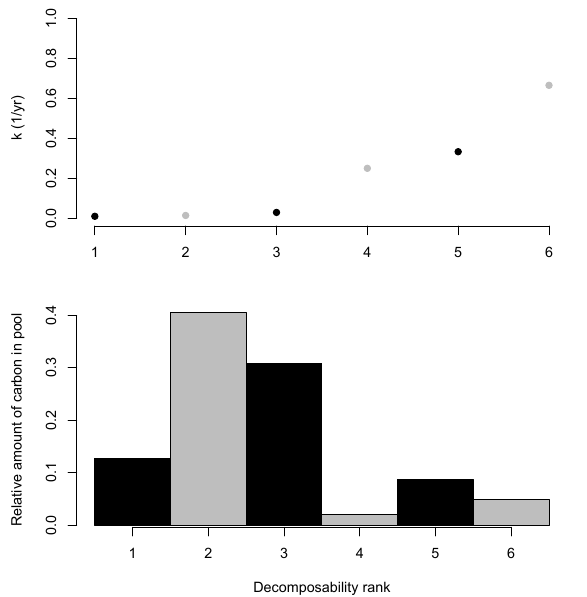
Fig. 6. Representation of the decomposition rate constants and pool sizes ranked by the value of the decomposition rate in the empiri- cal model proposed by Gaudinski et al. (2000). Black colors repre- sent pool sizes and decomposition rates for the mineral layer, and gray colors for the organic layer. Decomposability ranks match pool names in Fig. 1 as: 1: Mineral asso., 2: Oe/a, 3: A-LF ( < 80µm), 4: Oe/a L, 5: A-LF ( > 80µm), 6: Oi.